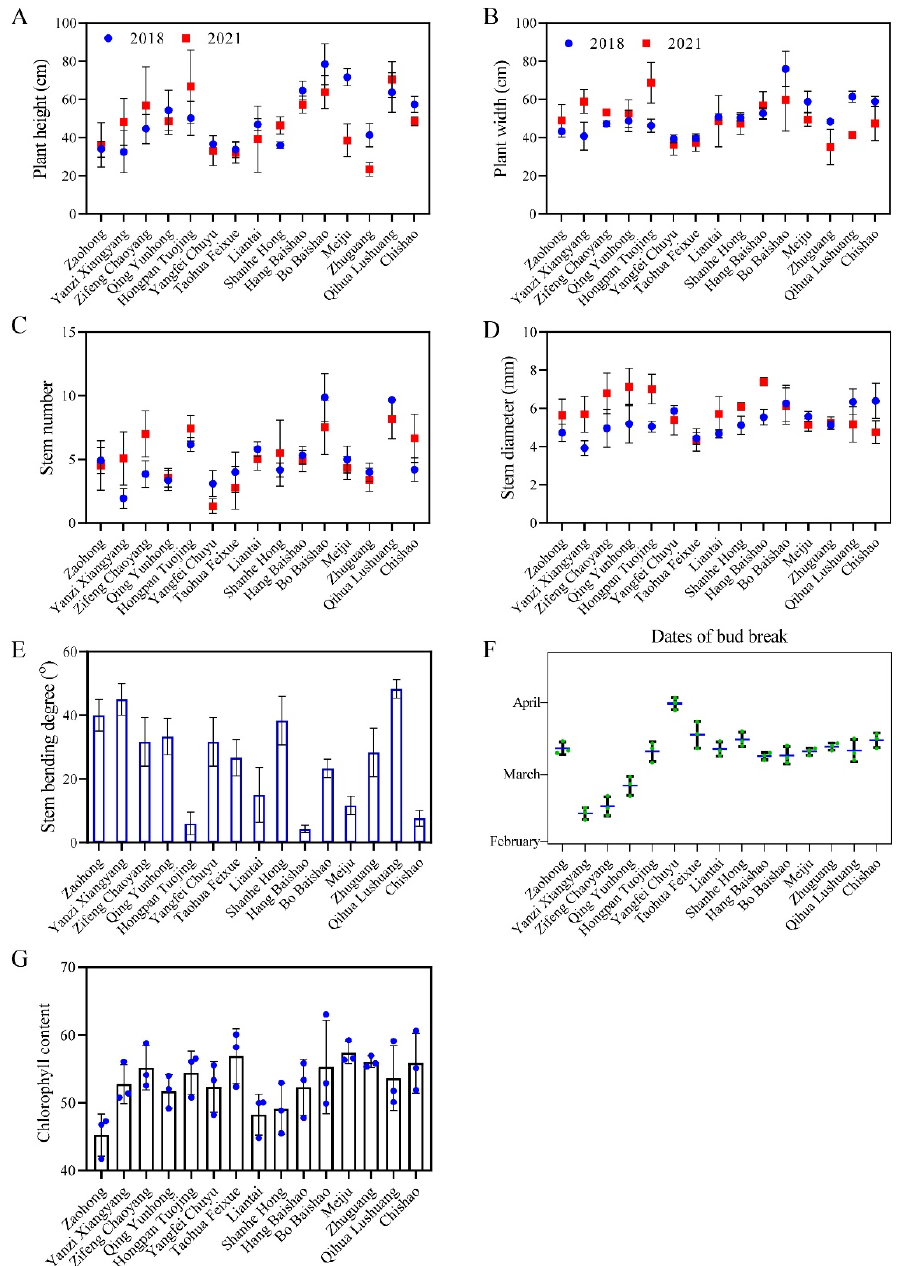
Figure 4. Observations and changes of growth habits-related indices of the fifteen peony cultivars.